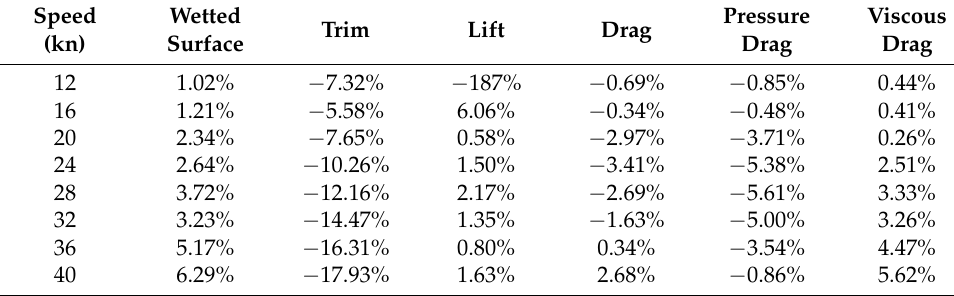
Table 12. Relative difference of global quantities: V4 vs. Table 11. Comparison of lift computed on SR.